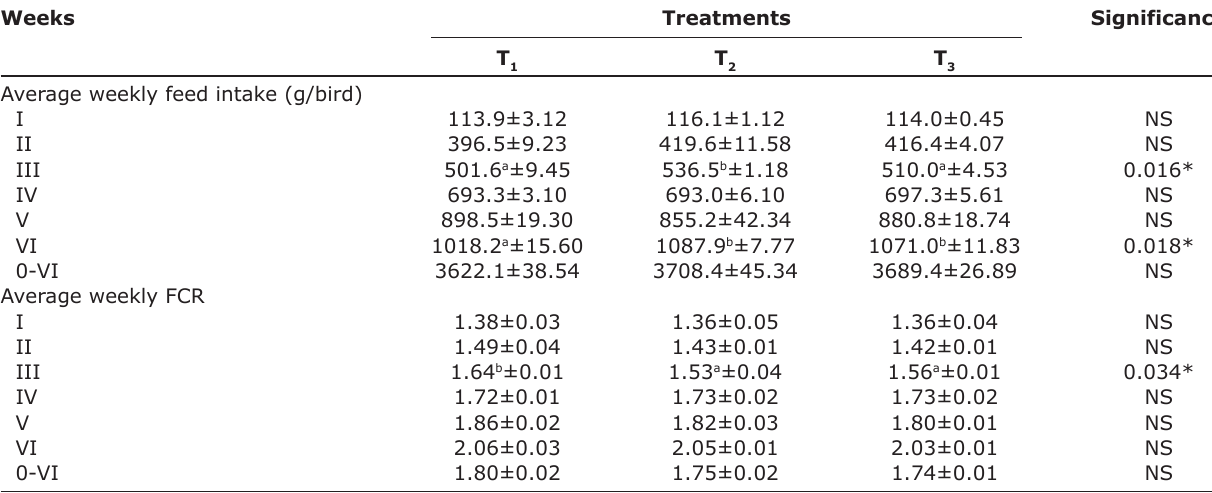
Table-3: Average weekly feed intake (g/bird) and FCR in broilers under different treatment groups.